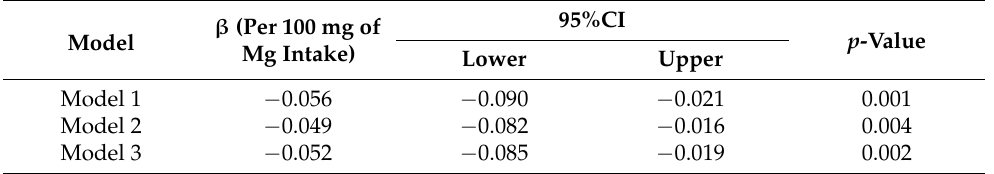
Table 4. A generalized linear model of the associations between dietary magnesium intake and fasting plasma glucose mean daily nutrient intake (energy-adjusted) (Mean ± SD).